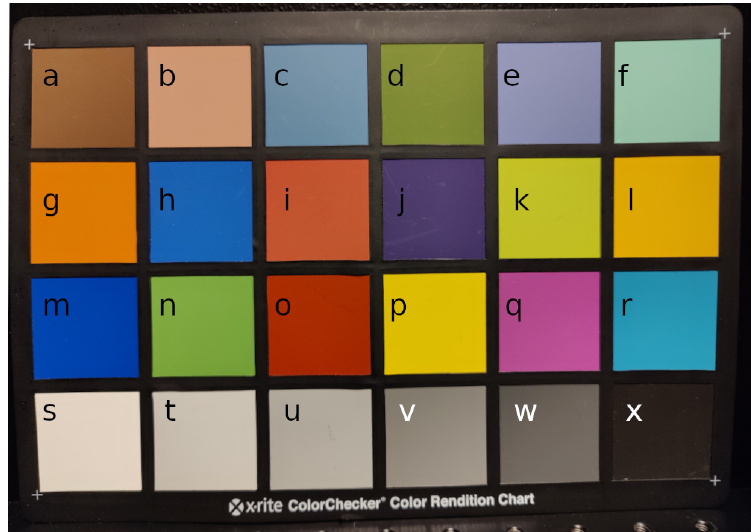
Figure 12. The color checker board used for calculating the result reflectances. Letters a–x correspond to each tile and a result plot in Figure 11. Table 2. Root mean squared differences and spectral angles (cosine) of measured spectra for each corresponding color checker tile, in Figure 12, compared to the averaged front view spectrum from central camera